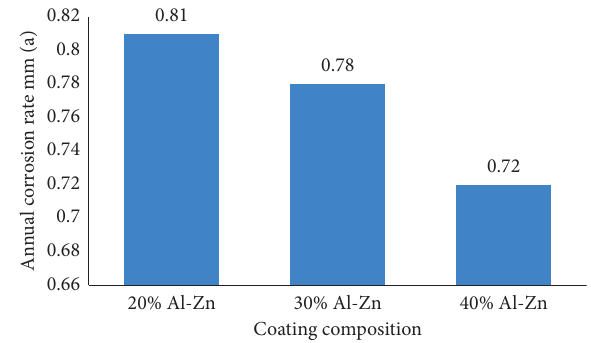
Figure 10: Corrosion rate of each coating.